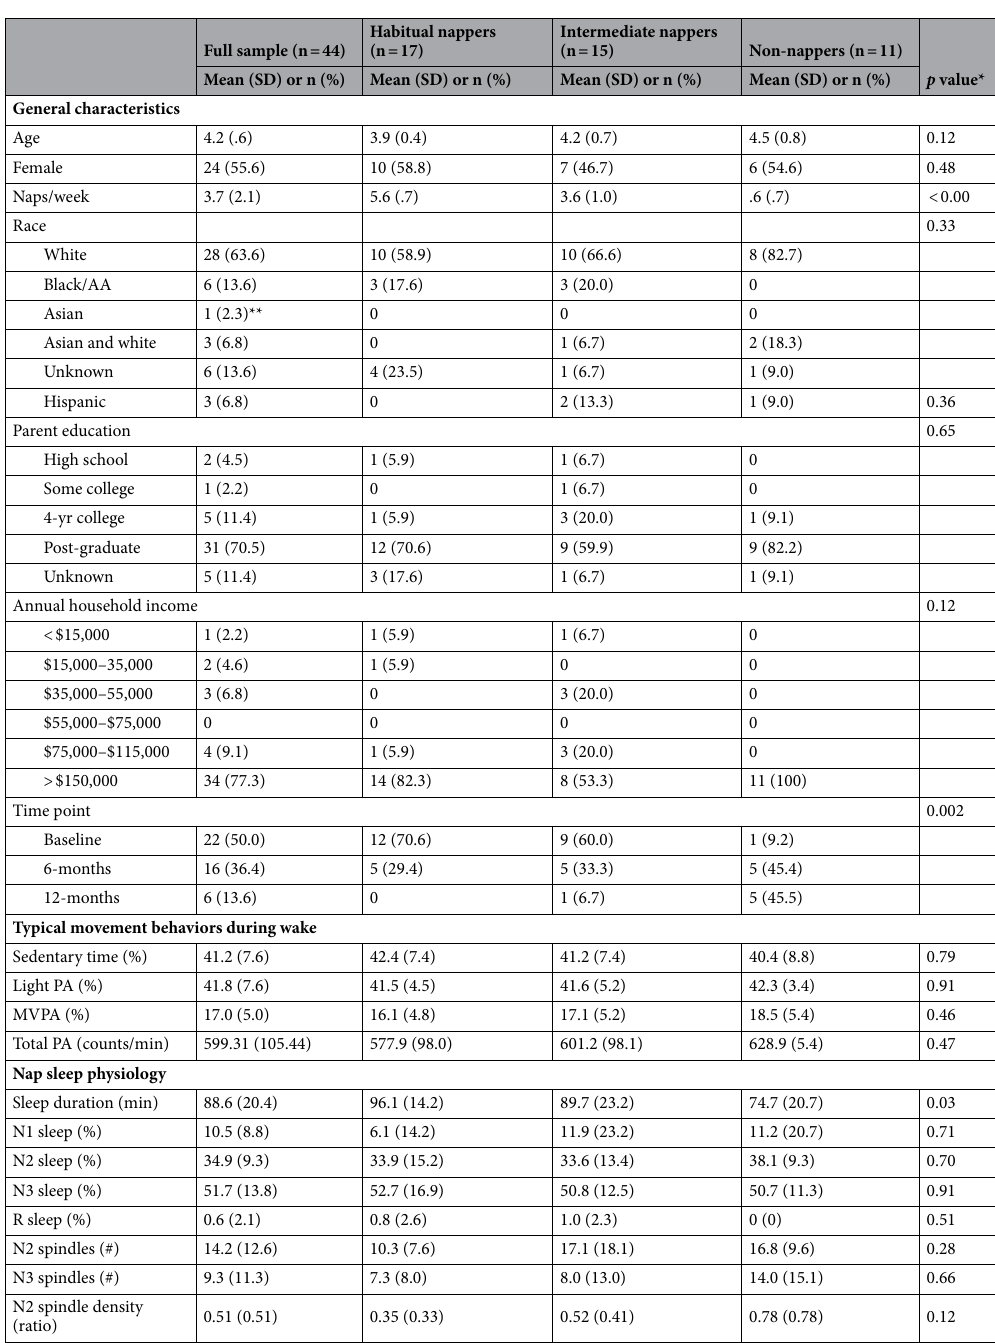
Table 1. Participant characteristics. *Differences in characteristics between nap habit groups (one-way ANOVA models for continuous variables, chi-square tests for categorical variables). **Data for nap habituality was missing for this